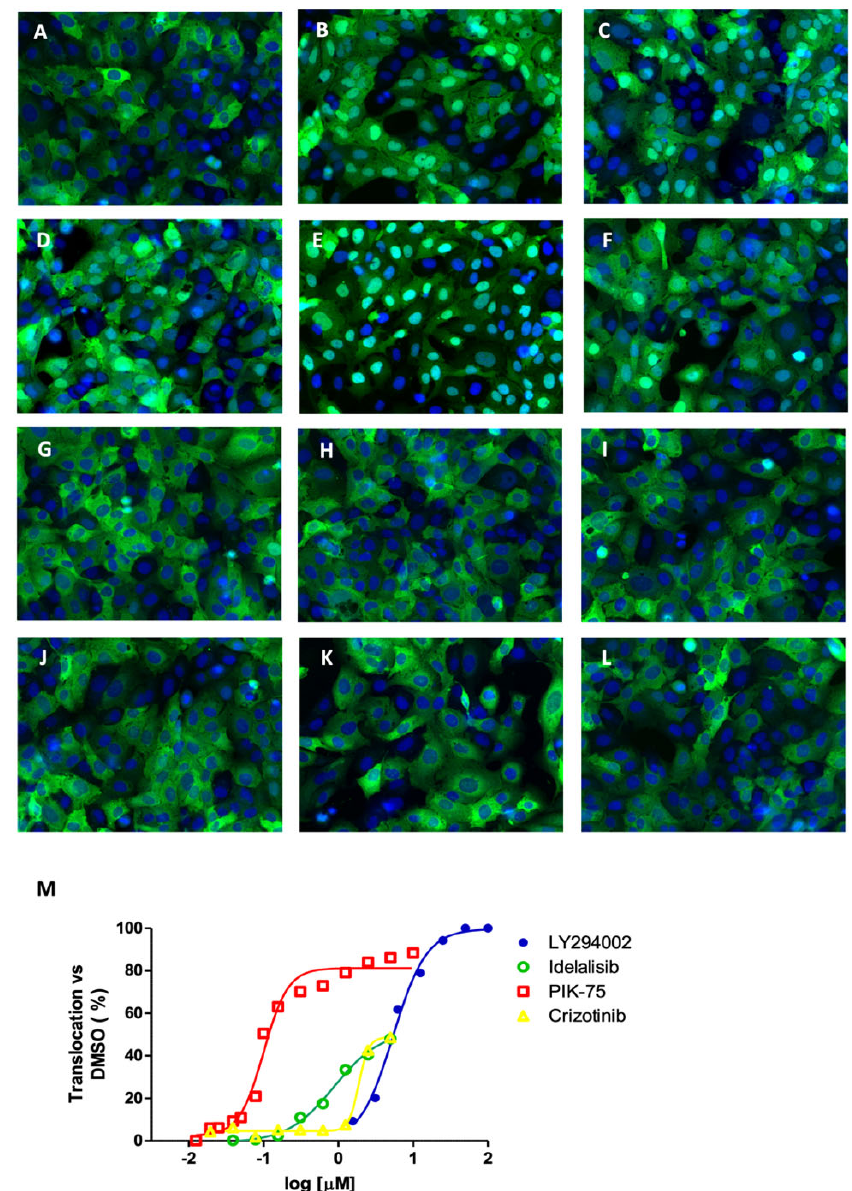
Figure 1. Second layer kinases effect on FOXO3 nuclear translocation. U2foxRELOC cells were treated either with ( A ) 0.5% DMSO, ( B ) 20 nM LMB, ( C ) 25 µ M LY294002, ( D ) 500 nM idelalisib, ( E ) 500 nM PIK-75, ( F ) 500 nM crizotinib, ( G ) 500 nM lenvatinib, ( H ) 500 nM lapatinib, ( I ) 500 nM erlotinib, ( J ) 500 nM afatinib, ( K ) 500 nM trametinib, ( L ) 500 nM SCH772984 for 60 min. Representative images at 20 × magnification are shown. ( M ) Dose-response representation of positive compounds tested